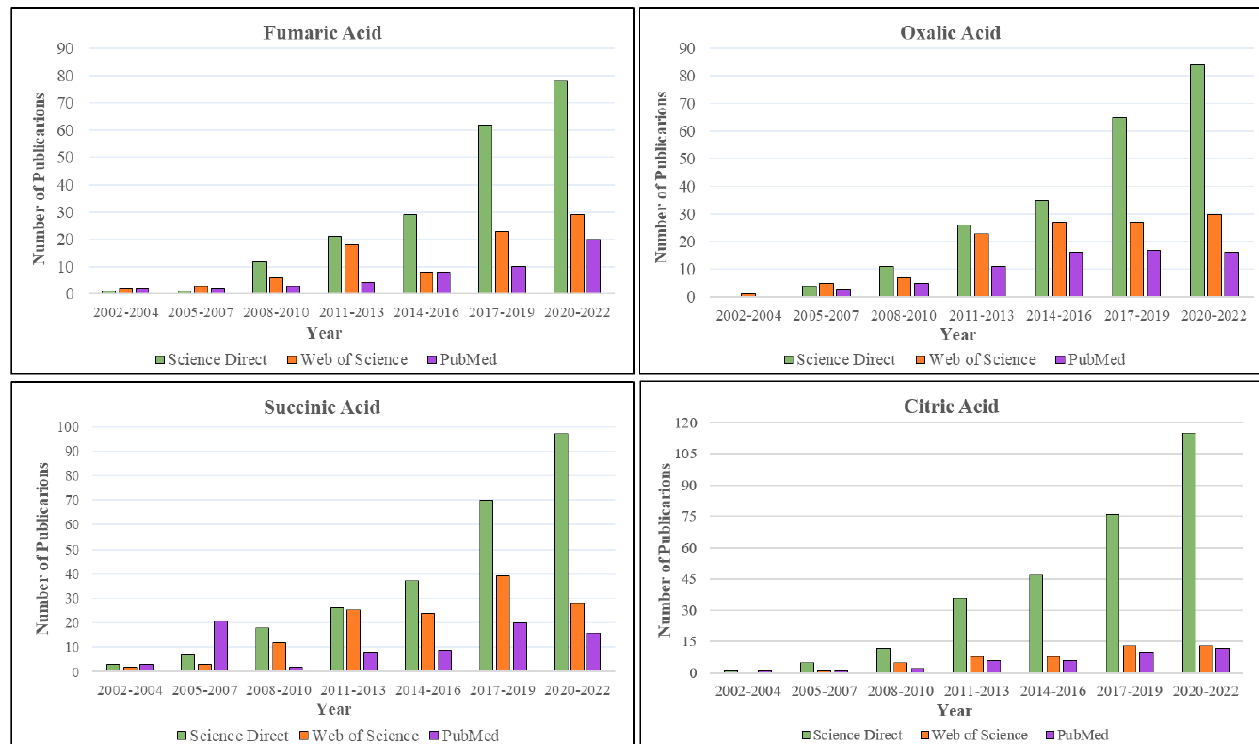
Figure 12. Literature trend of carboxylic acid ‐ based coformers usage in preparation of cocrystals.